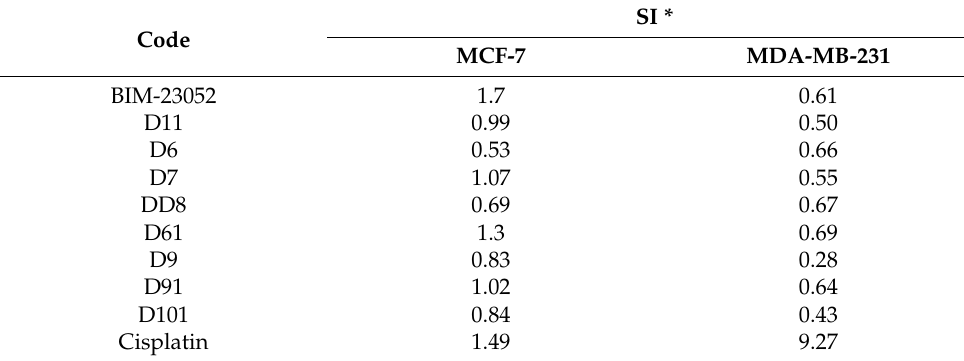
Table 4. Selectivity of the studied BIM-23052 analogs.